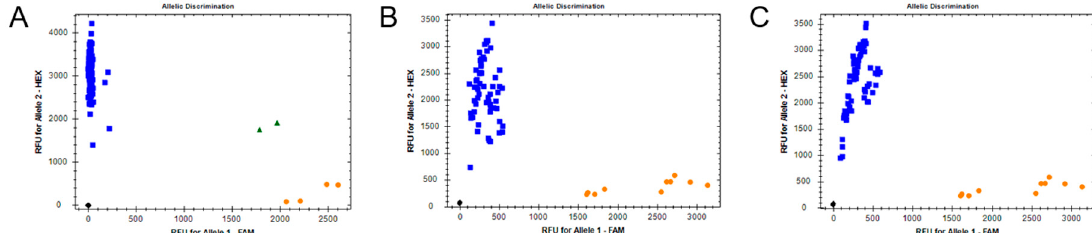
Figure 4. Detection of the RyR I4790M mutation using an allele-specific real-time PCR fluorescent probe assay, as recently described by Boaventura et al. (2020). ( A ) Genotyping of Spodoptera frugiperda collected in Puerto Rico represented by blue squares (wildtype SS homozygotes, I4790 allele), orange circles represent strain Chlorant-R mutant RR homozygotes from Brazil (M4790; allele 1) and green triangles artificial SR heterozygotes (I4790 / M4790). All individuals tested from ( B ) Kenya and ( C ) Indonesia were susceptible homozygotes for I4790 (blue squares).